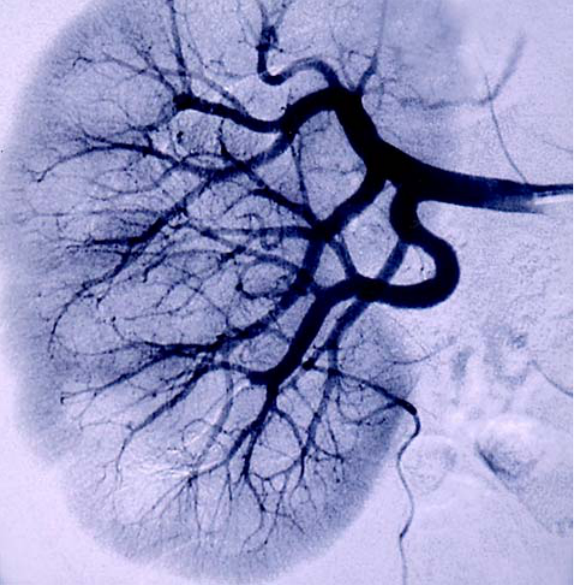
Figure 2 – Control angiography show that there is no opacification of the